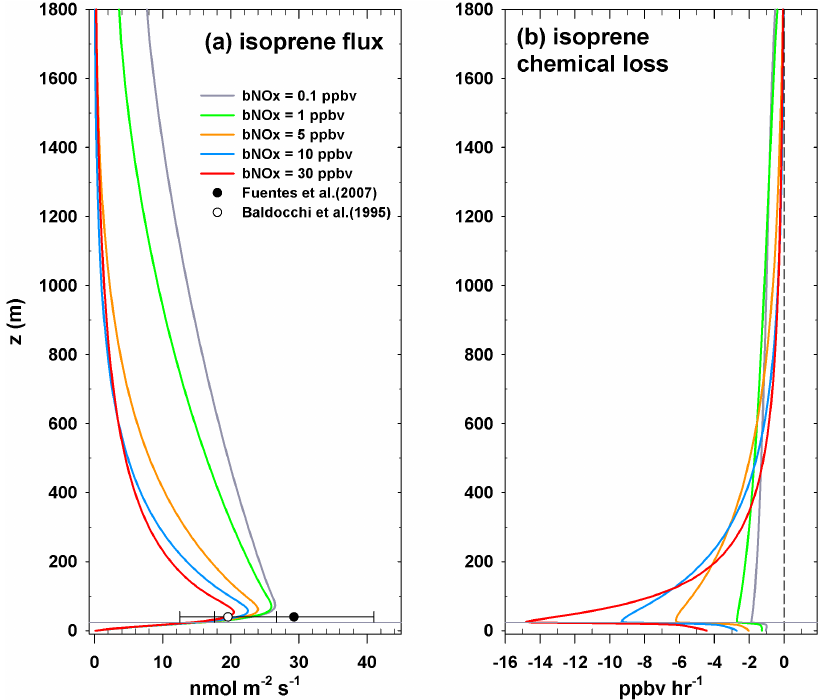
Fig. 8. Steady-state profiles of (a) isoprene vertical flux (nmolm − 2 s − 1 ) and (b) isoprene chemical loss (ppbvh − 1 ) for each background NO x value (horizontal gray line is canopy top height). Measured isoprene flux data (means ± 1 standard deviation) from Baldocchi et al. (1995) and Fuentes et al. (2007) for Walker Branch Watershed.